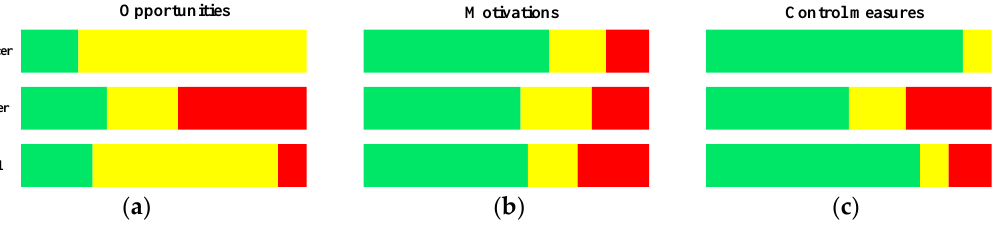
Figure 3. The percentage of vulnerability to different fraud factors in the baijiu supply chain. Note: ( a ), ( b ), and ( c ) present the vulnerability of the opportunities, motivations, and control measures for producer, retailer, and total, respectively; Green, yellow, and red represent low, medium, and high vulnerabilities, respectively.